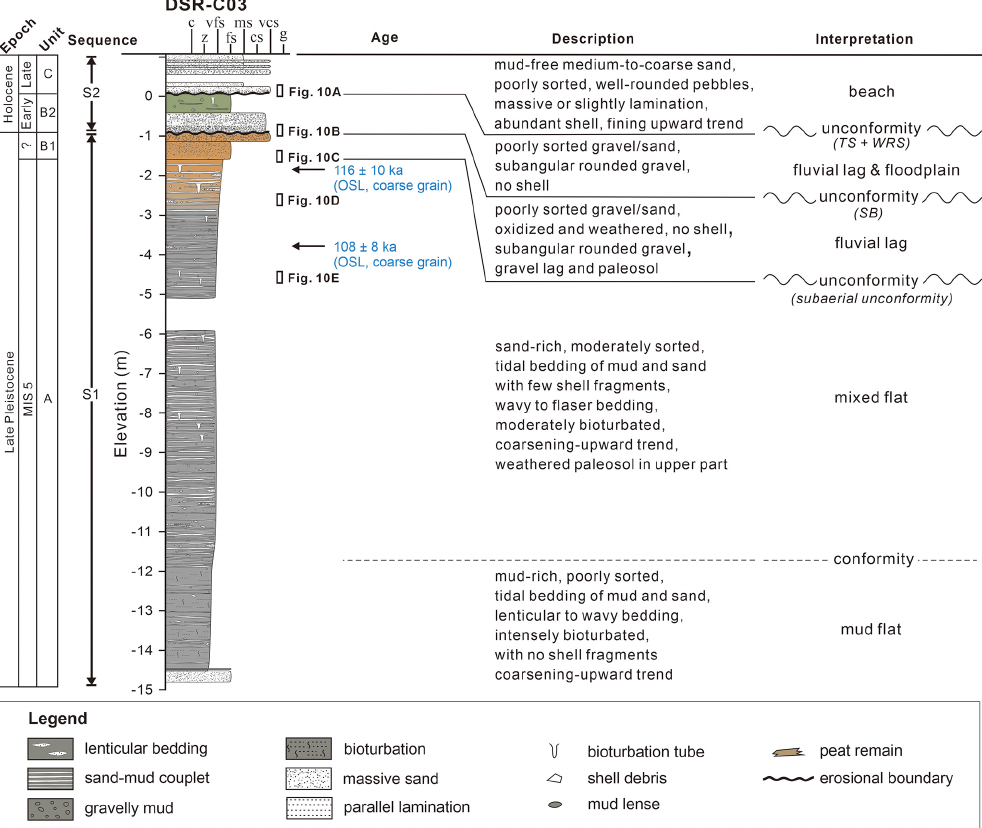
Figure 9. Schematic columnar section of core DSR-C03 including lithology and OSL ages (for the OSL ages, see Chang et al., 2017). Two ages in blue indicate LIG ages (WALIS LUM ID no. 470 and no. 471 in Table 3). For the location of the core, see Fig. 7. TS: transgressive surface; WRS: wave ravinement surface; SB: sequence